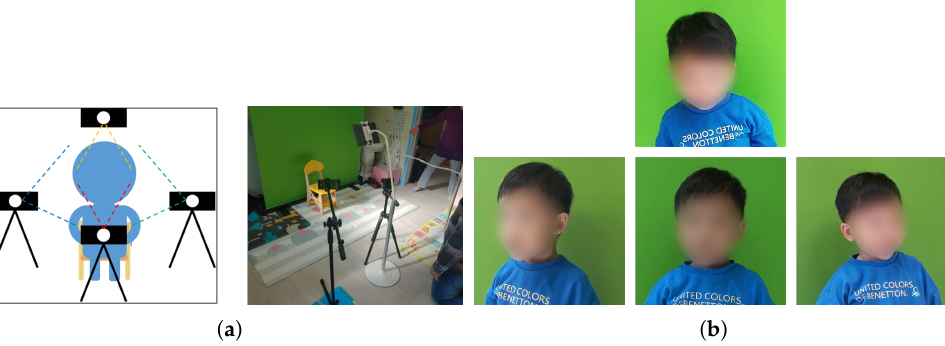
Figure 3. Face data collection for children aged 2 to 4: ( a ) camera position; ( b ) example.